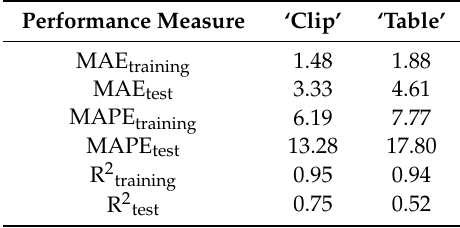
Table 5. Estimates of prediction performance for of spike density index for one (‘table’) and four (‘clip’) projections (MAE training and MAE test , mean absolute errors for training and test samples; MAPE training and MAPE test , mean absolute percent errors for training and test samples; R 2 training and R 2 test , Pearson correlation coe ffi cient between the predicted and expert estimates for training and test